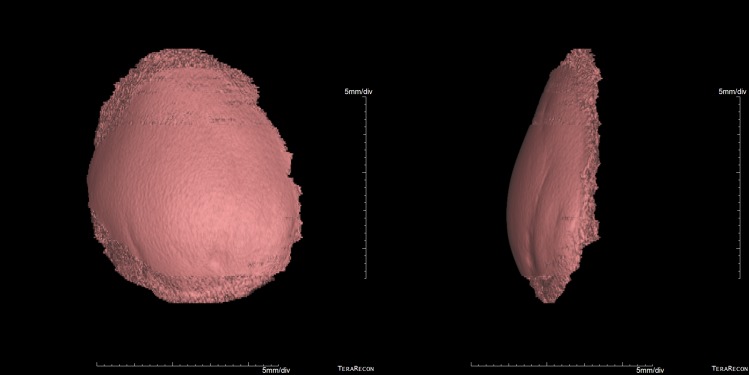
Reconstructed images of the flap.Anterior view and lateral view of reconstructed images.